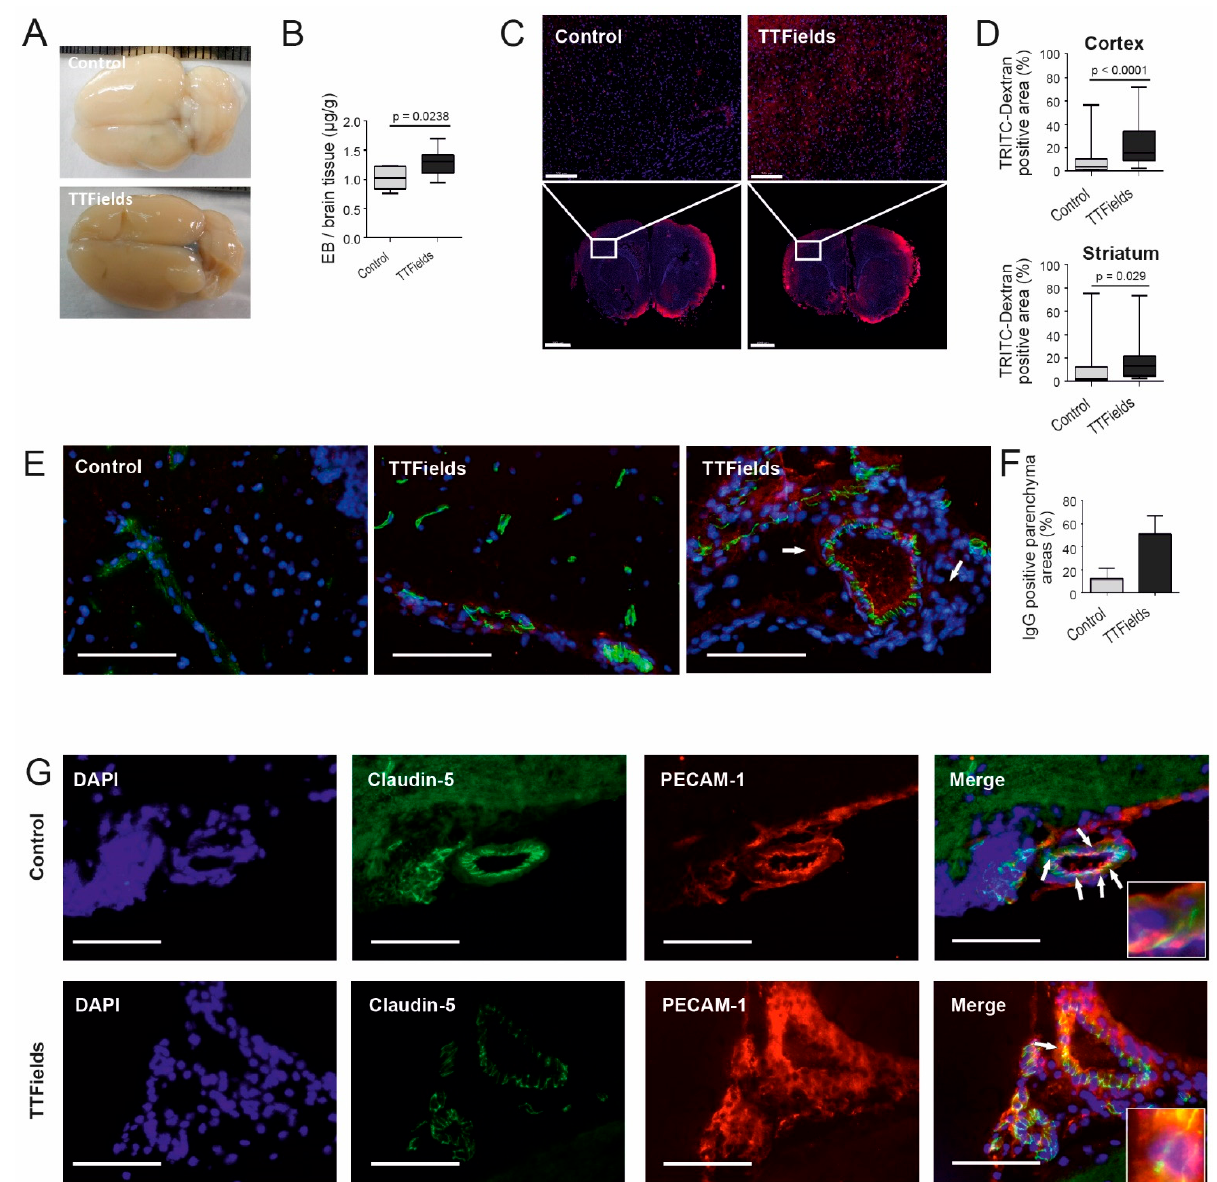
Figure 4. TTFields at 100 kHz for 72 h increased vessel permeability. ( A ) Whole brain images from rats injected intravenously with EB following 72 h treatment with TTFields ( n = 10) or sham heat ( n = 6). ( B ) Quantification of EB extracted from perfused rat brain following treatment based on absorbance measurements at 610 nm. ( C ) TD (red) accumulation in the brain parenchyma following TTFields. Nuclei were stained with DAPI (blue). Scale bars = 200 (upper) and 2000 µ m (lower), respectively. ( D ) Uptake of TD by the cortex (upper) and the striatum (lower) of treated animals, as evaluated by measuring the TD autofluorescence. ( E – G ) Immunofluorescence staining of rat brain cryosections. ( E ) Cells were stained with antibody against TJ protein claudin-5 conjugated to Alexa Fluor 488 (green) and IgG (red). The control and the first TTFields image show longitudinal sections of blood vessels. The right image shows a cross-section of a TTFields-treated vessel. Arrows indicate delocalization of TJ proteins and areas of IgG extravasation. ( F ) Quantification of IgG extravasation into the brain parenchyma. Slide preparations were photographed under the fluorescence microscope and the percentage of IgG-positive parenchyma areas was calculated. ( G ) Double staining of claudin-5 (green) with PECAM-1 (red), producing a merged image of yellow within points of colocalization, which are indicated by arrows and shown in high magnification in the inlays. Nuclear staining with DAPI (blue). Magnification 40 × , scale bar = 100 µ